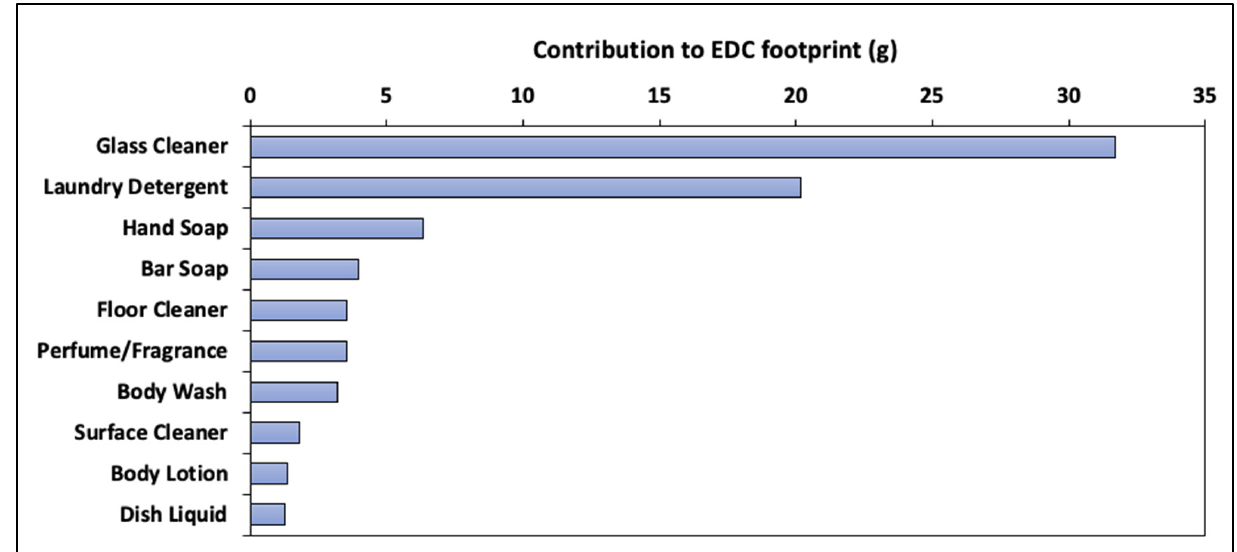
Figure 4. Example of endocrine-disrupting compound (EDC) footprint calculator results for the top 10 products and their contribution to the overall EDC footprint for one example user.